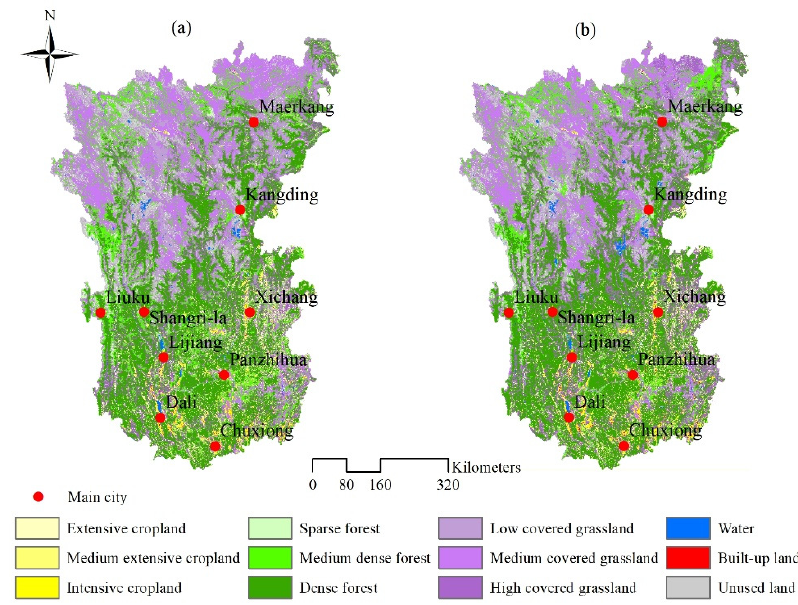
Figure 4. Results of land system delineation in ( a ) 2000, ( b ) 2010.